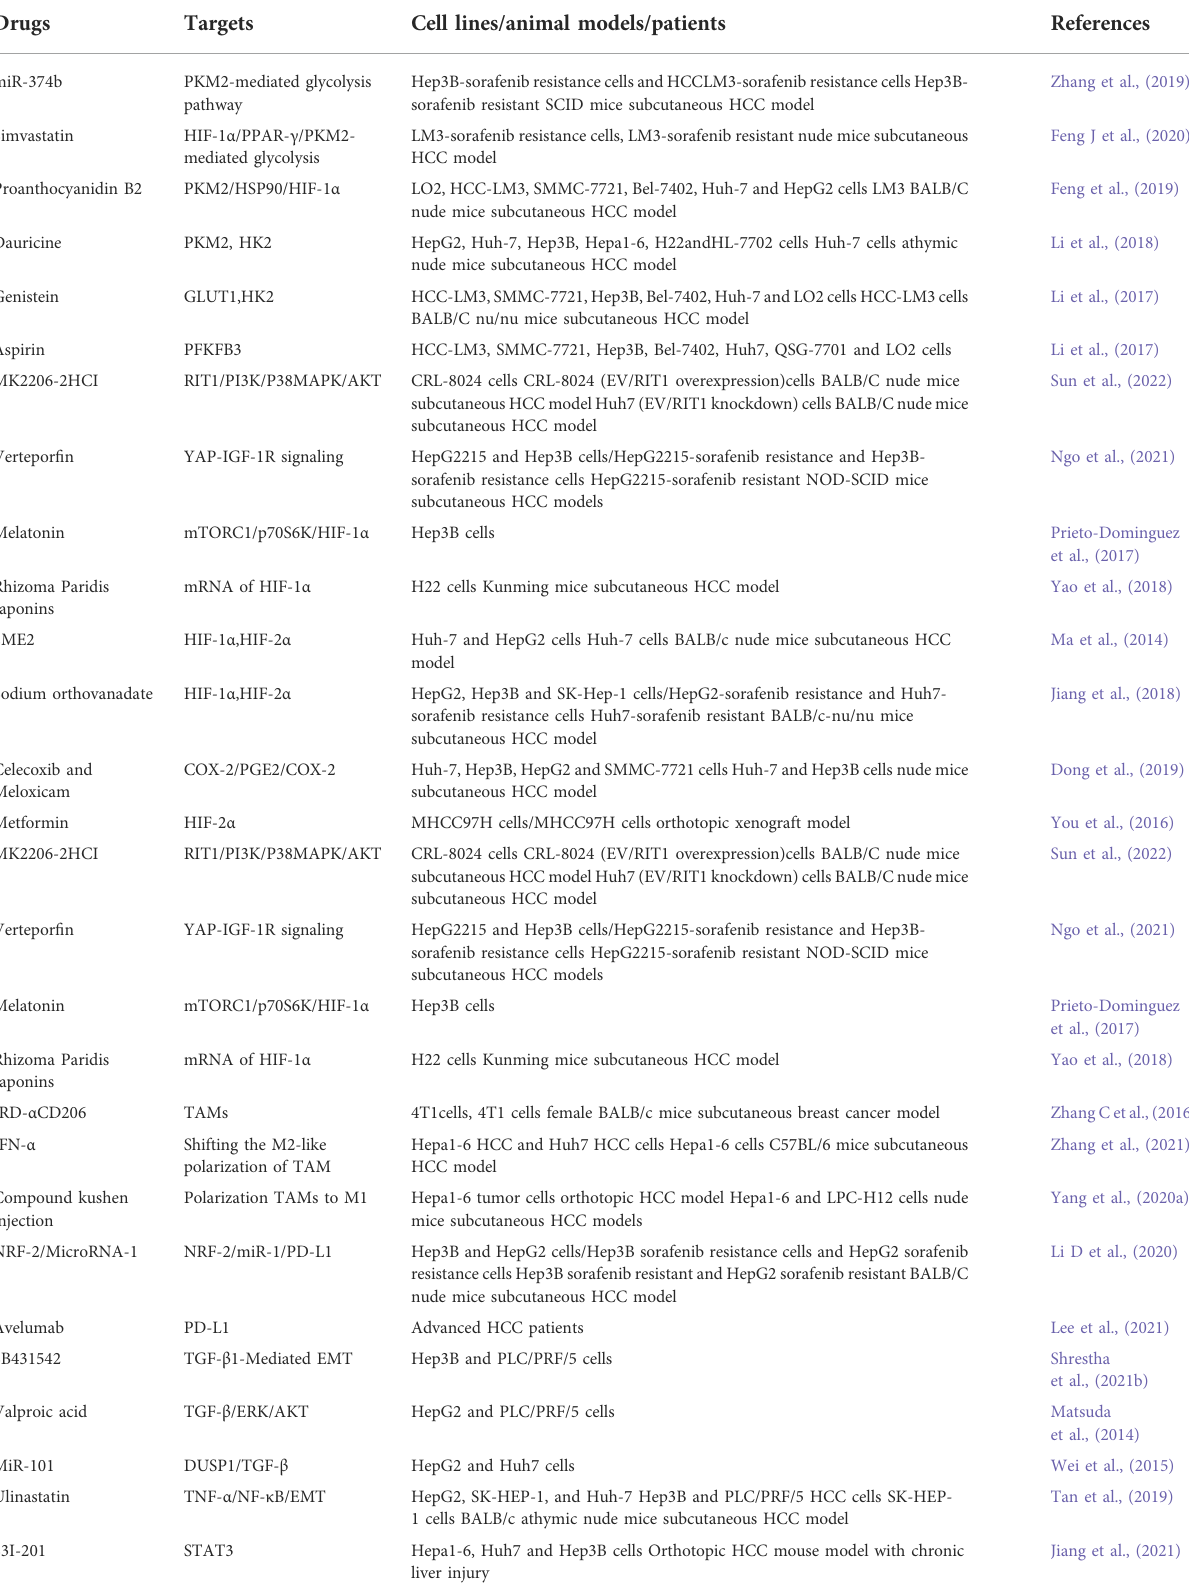
TABLE 2 Therapeutic approaches target TME to overcome sorafenib resistance in